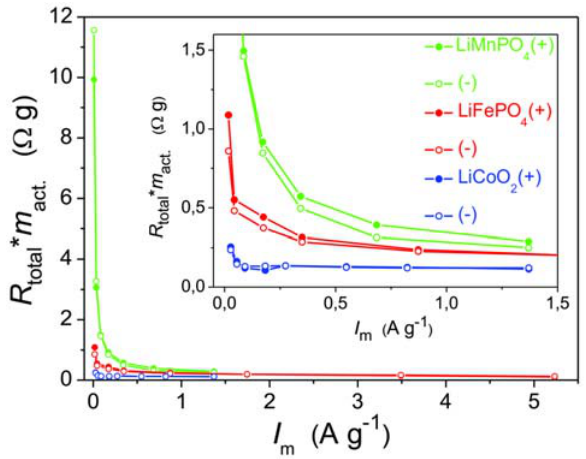
Figure 6. Total resistance of cell, R (red) and LCO- (blue) based cells obtained using Eq. 4. The over- potential values were extracted using the inflection point criteria (see also data shown in Fig. 4). In order to compare different elec- trodes the resistances were mass-normalized R the mass of active material. The obtained values of R charge and discharge are denoted with (+) and (–),